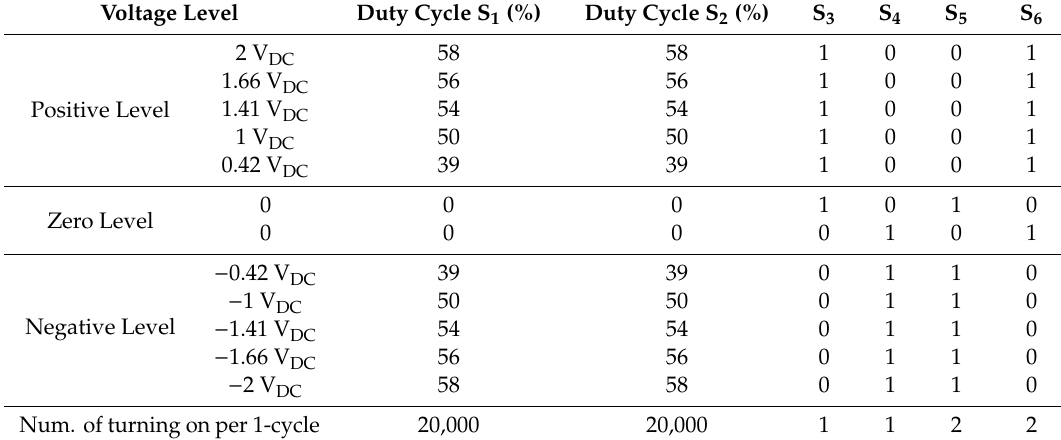
Table 3. Switching table level = 11, gain = 2.